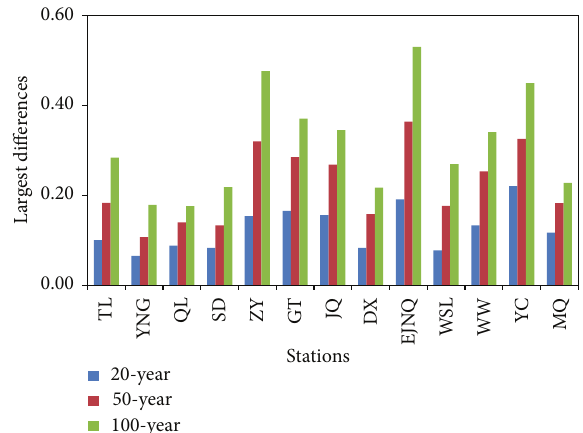
Figure 7: The largest difference in the estimated annual maximum precipitation derived from the alternative models and the best fitted ones on different return